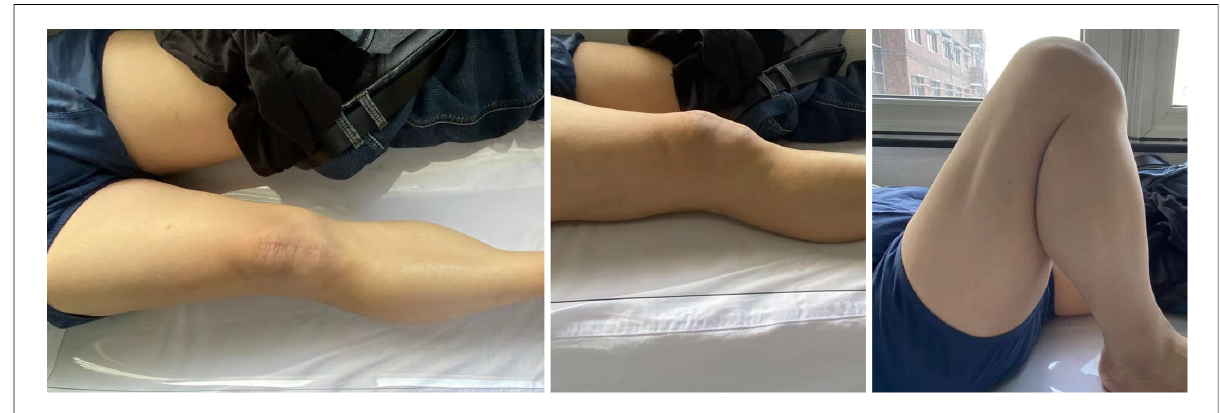
FIGURE 4 Final follow-up clinical photographs showing satisfactory extension and fl